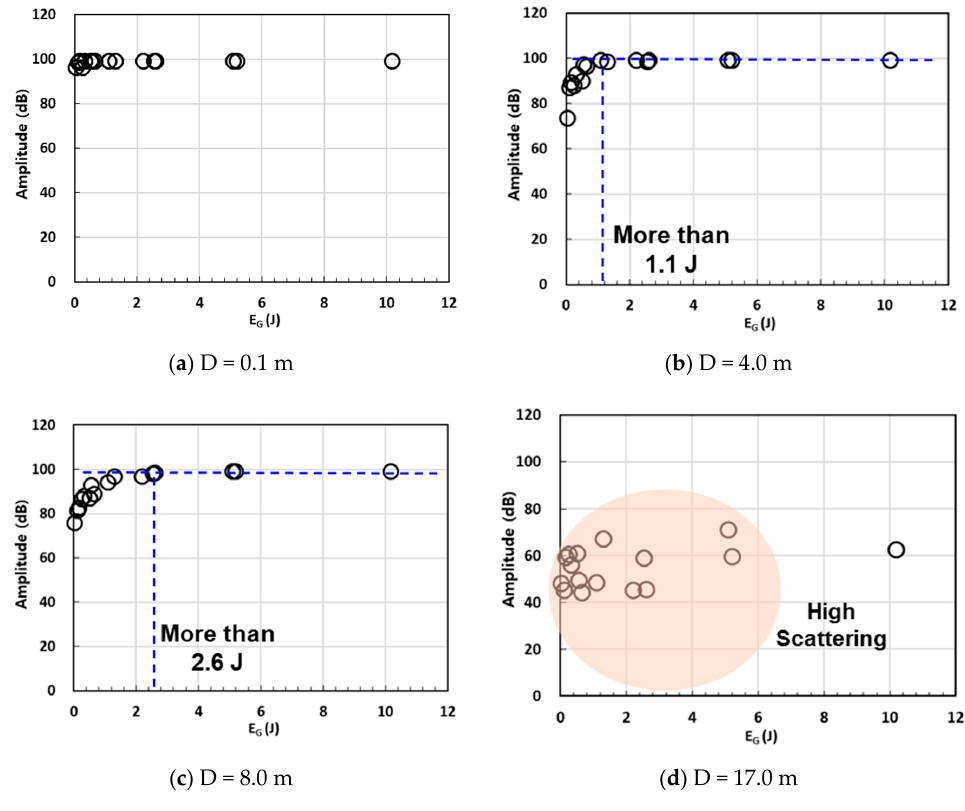
Figure 8. Amplitude according to impact energy.